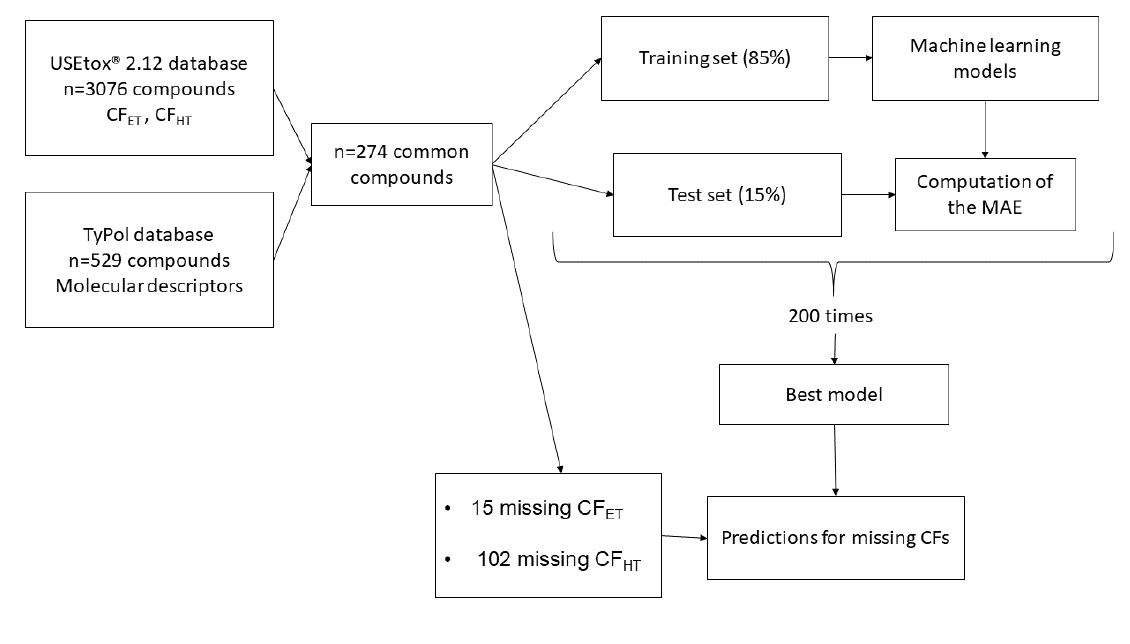
Figure 1 Schematic representation of the modeling procedure adopted in the